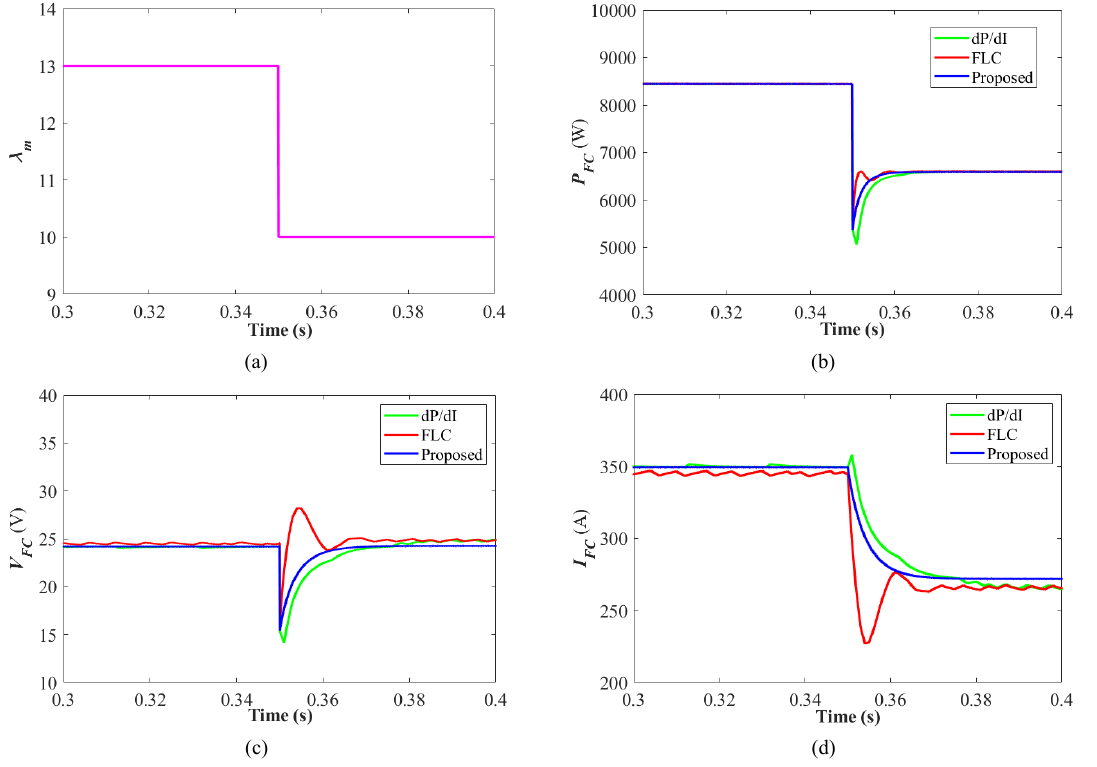
Figure 13. Results and comparisons at scenario 1: ( a ) λ m ; ( b ) P FC ; ( c ) V FC ; ( d ) I FC